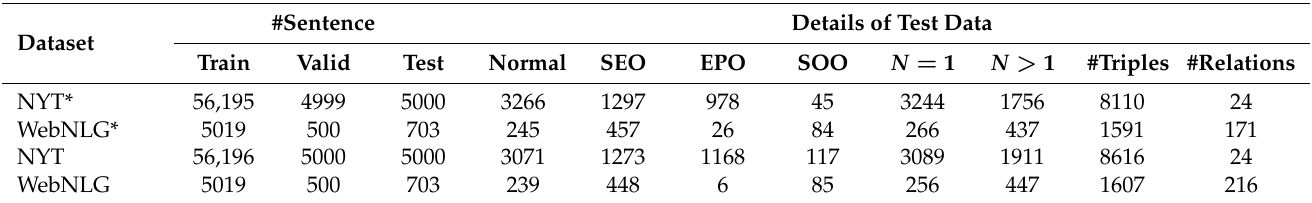
Table 1. Statistics of four datasets used in our experiments, where N is the number of relational triples in a sentence.We divided the overlapping patterns into four categories: Normal, Single Entity Overlap (SEO), Entity Pair Overlap (EPO) , and Subject Object Overlap (SOO) . Details of Test